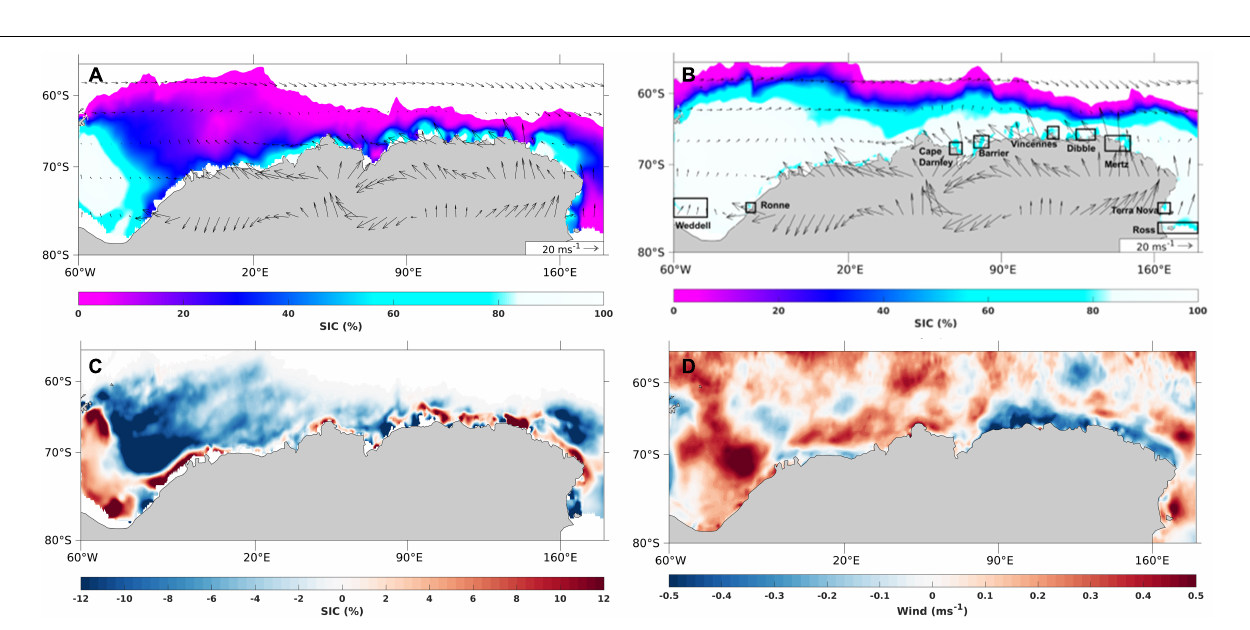
FIGURE 4 | Climatological sea-ice concentration ( SIC ) (1979–2015) shows nine coastal polynyas with the prevailing pattern of south-easterly wind anomaly during (A) summer and (B) winter. (C) Summer sea-ice anomaly for 2016–2020. (D) Summer wind anomaly for 2016–2020. The anomalies were computed relative to a 37-year climatology